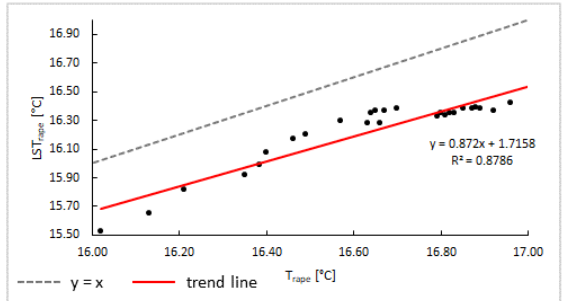
Figure 11. Correlation of the retrieved surface temperature ( LST rape ) and measured surface temperature ( T rape ) during flight 1 over the rapeseed experiment (11 April 2018, 13:34–13:49